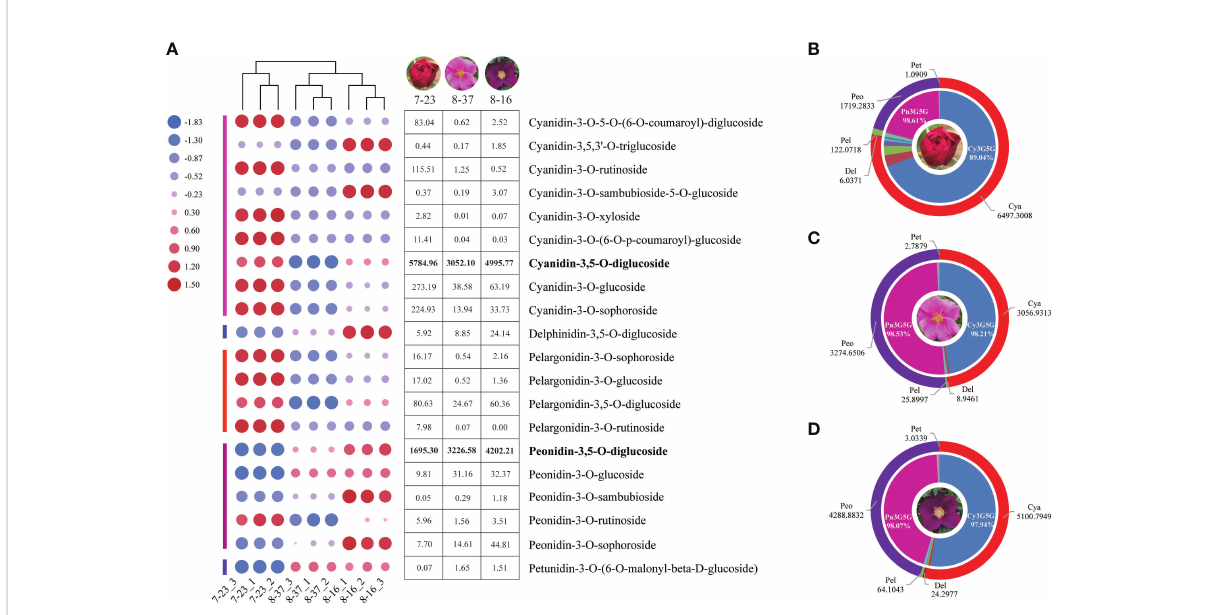
FIGURE 1 Anthocyanin type and content analyses in three R. rugosa germplasms. (A) Change trends of 20 main anthocyanins in 7-23, 8-37, and 8-16. (B) Anthocyanin distribution in petals of 7-23. (C) Anthocyanin distribution in petals of 8-37. (D) Anthocyanin distribution in petals of